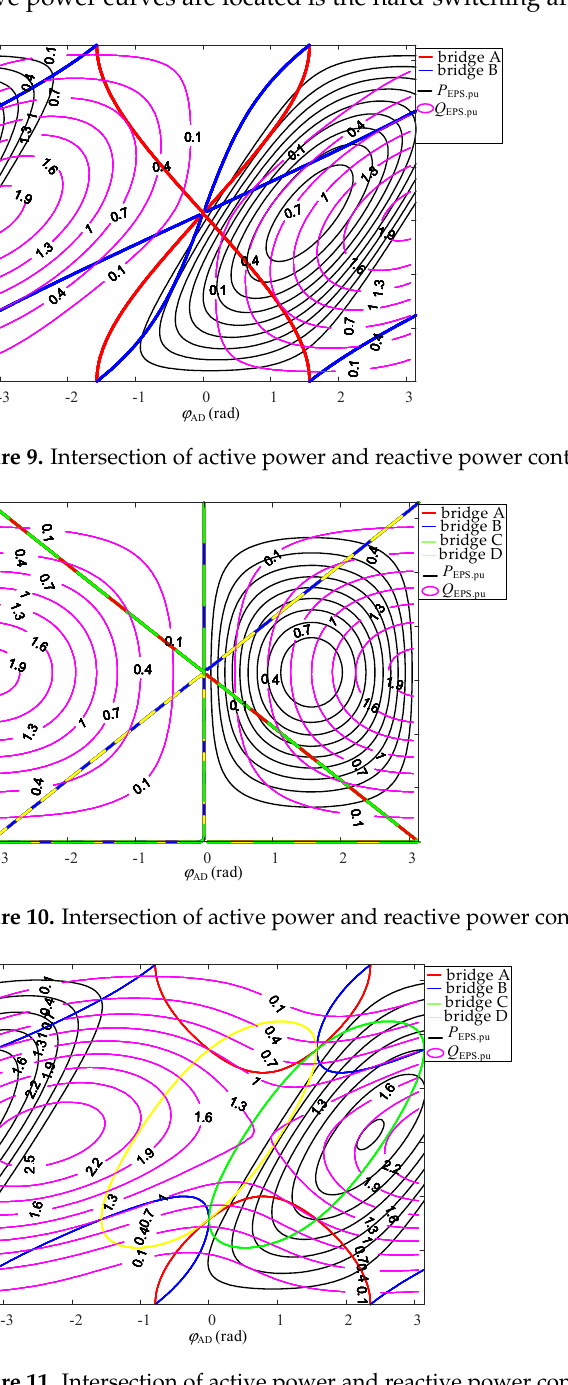
Figure 11. Intersection of active power and reactive power contours under TPS modulation ( M = 1).